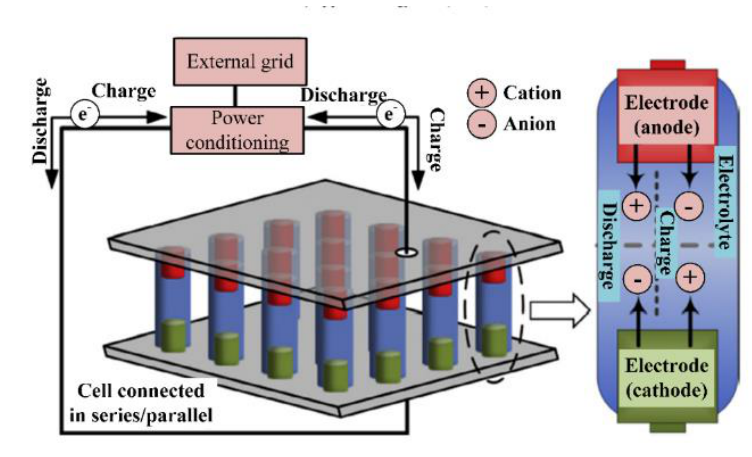
Figure 20. Schematic diagram of a battery energy storage system (BESS) operation, where energy is